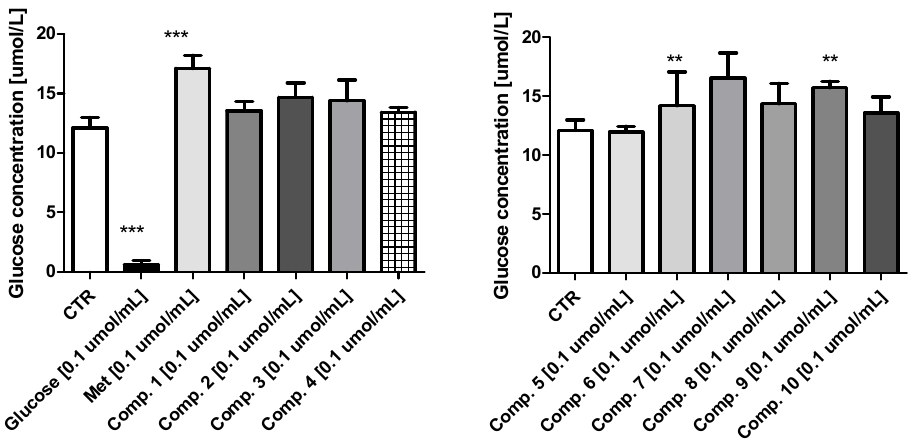
Figure 1. Effects of metformin and synthesized compounds 1 – 10 , and ᴅ -glucose on the 2-NBDG (2-(N-(7-Nitrobenz-2-oxa-1,3-diazol-4-yl)Amino)-2-Deoxyglucose) uptake in human umbilical vein endothelial cells (HUVEC) cells. The cells were treated with the tested compounds for 24 h prior to the experiments. On the day of the experiment the cells were glucose-starved for 2 h, then incubated with insulin (30 min), and in sequence with 2-NBDG for 45 min. The results are presented as mean ± SD, n = 4–6. Significant di ff erences in glucose uptake are denoted with asterisk; ** p < 0.01, *** p < 0.001.